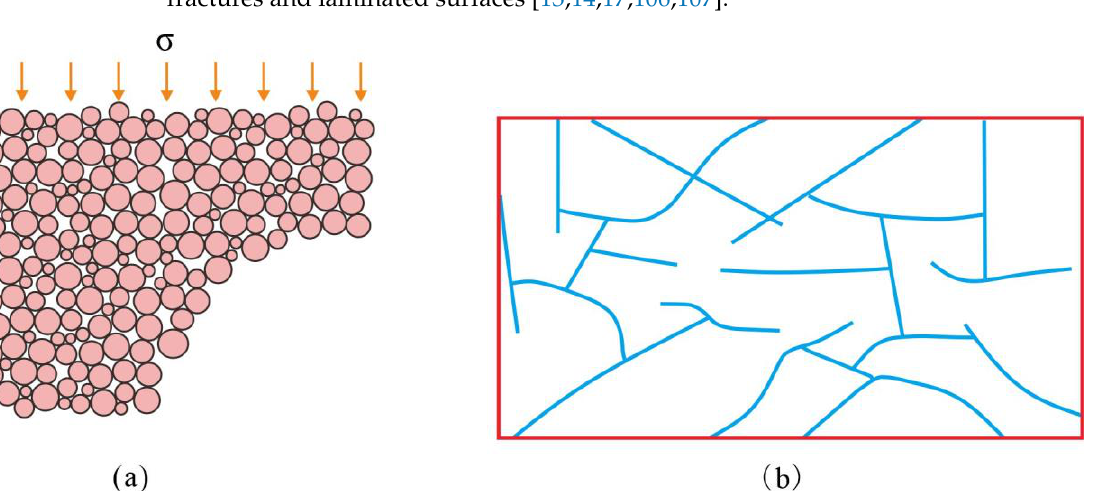
Figure 6. Simulation of hydraulic fracture propagation by discrete element method [28,108]: ( a ) Discrete particle distribution, ( b ) Unconventional fracture network distribution, blue represents cracks.